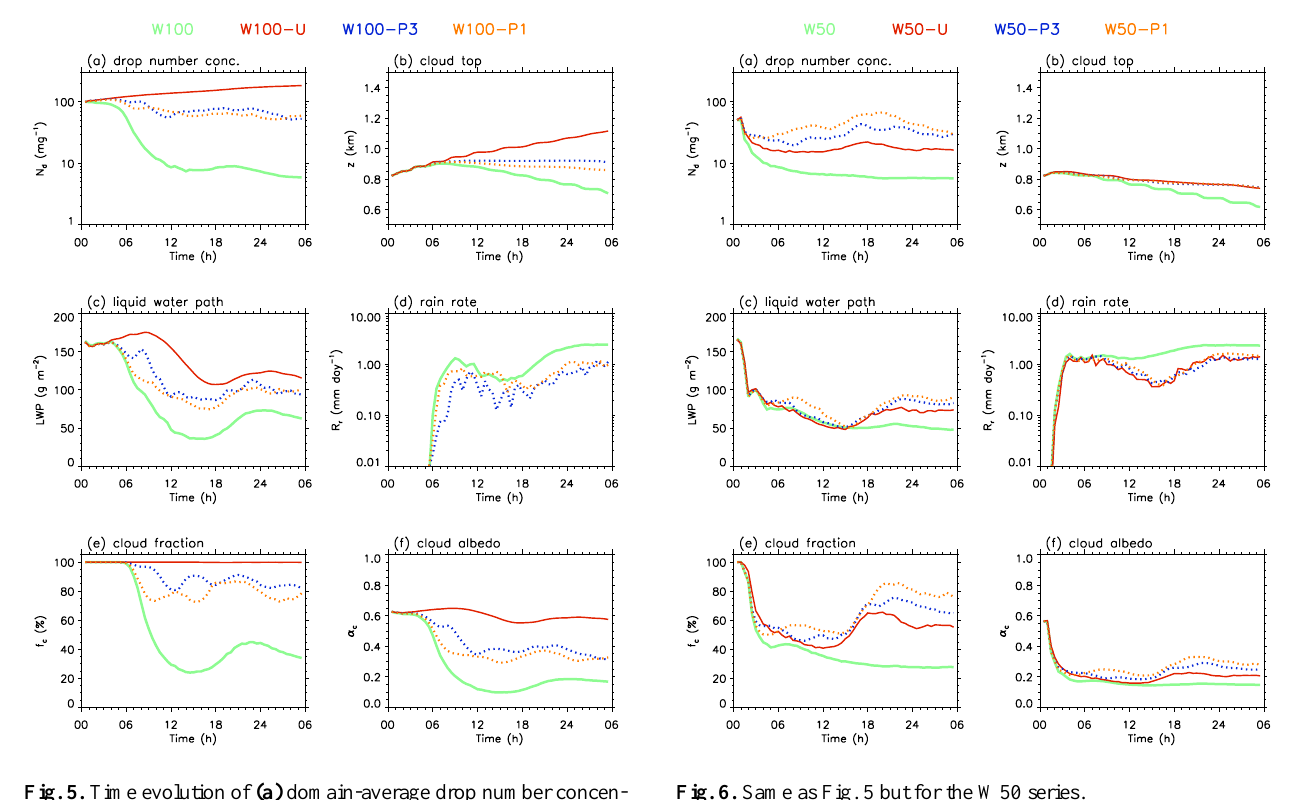
Fig. 5. Time evolution of (a) domain-average drop number concen- tration ( N d , mg − 1 ) ; (b) cloud-top height; (c) domain-average liquid water path, LWP (gm − 2 ); (d) domain-average surface rain rate ( R r , mmd − 1 ); (e) cloud fraction; and (f) domain-average cloud albedo α c for experiments in the W100 series. Cloud fraction is defined as the fractional coverage of the domain by clouds with an optical depth greater than 2.